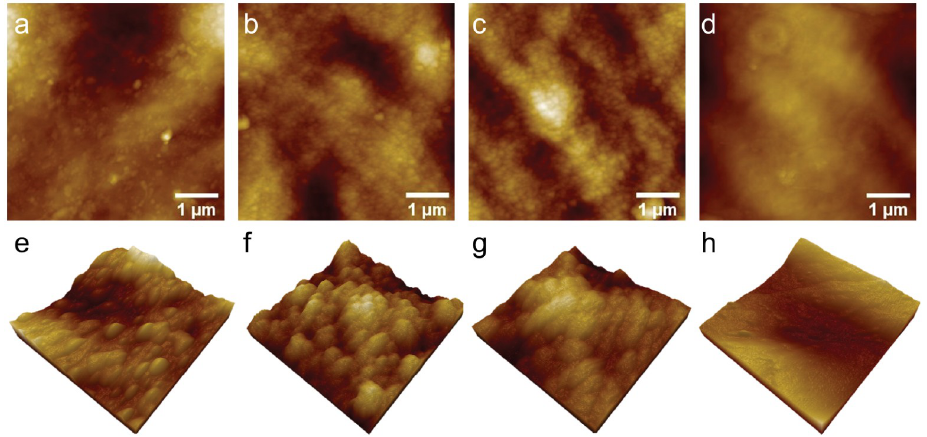
Fig 3. The AFM images of samples with different treatments. The AFM images of 5 μ m x 5 μ m areas (a)-(d) and zoomed-in 3D AFM images of 1 μ m x 1 μ m areas collected from AgNP-4ATP-OEC,AgNP-4ATP soaked-OEC, AgNP-OEC and freshly peeled OEC, respectively.